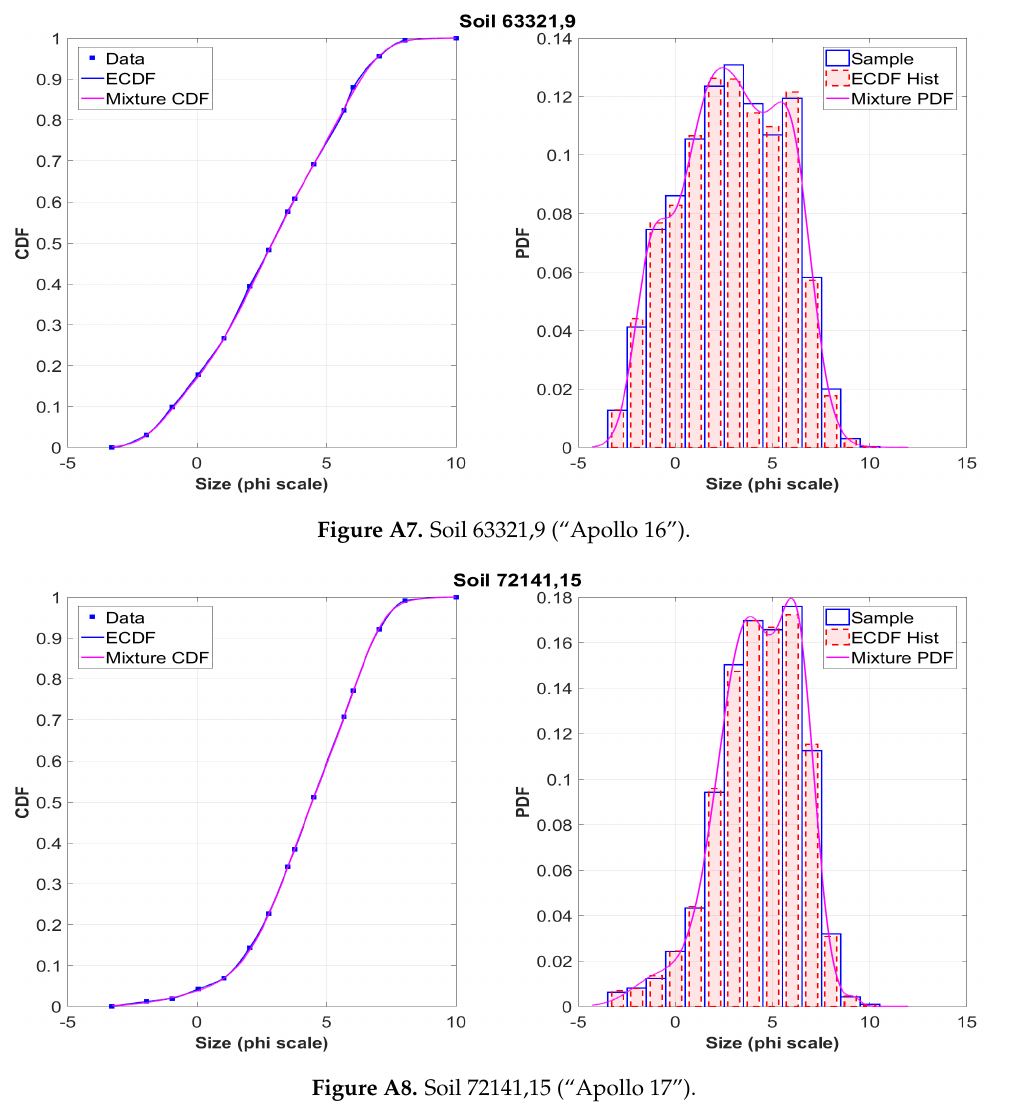
Figure A8. Soil 72141,15 (“Apollo 17”).